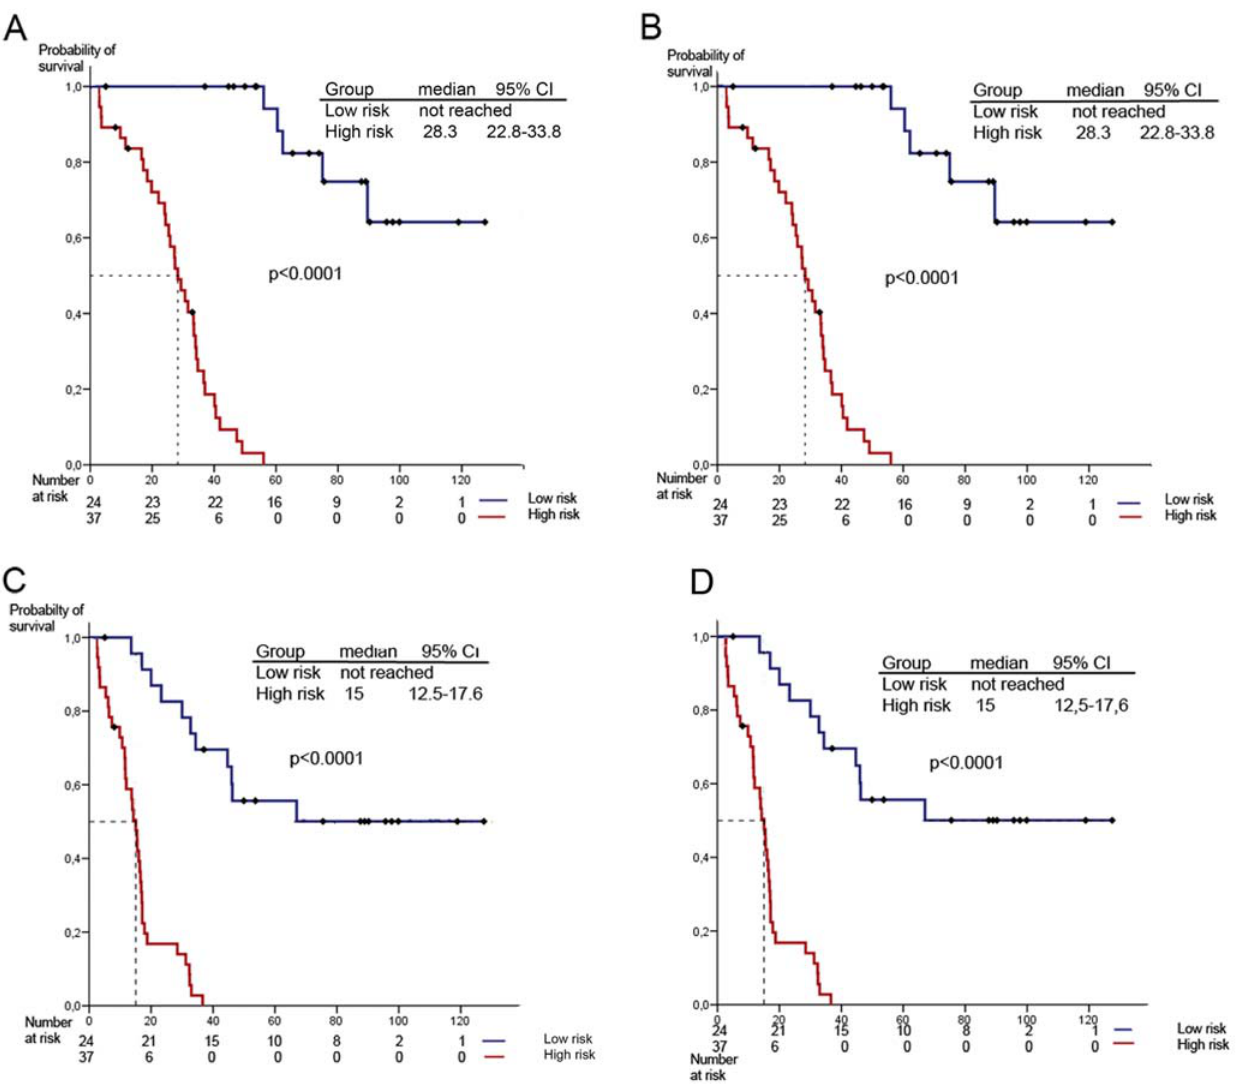
Figure 1. Kaplan-Meier OS curve of low risk versus high risk group (A). Kaplan-Meier curve after LOOCV (B). Kaplan-Meier PFS curve of low risk against high risk (C). Kaplan-Meier curve after LOOCV